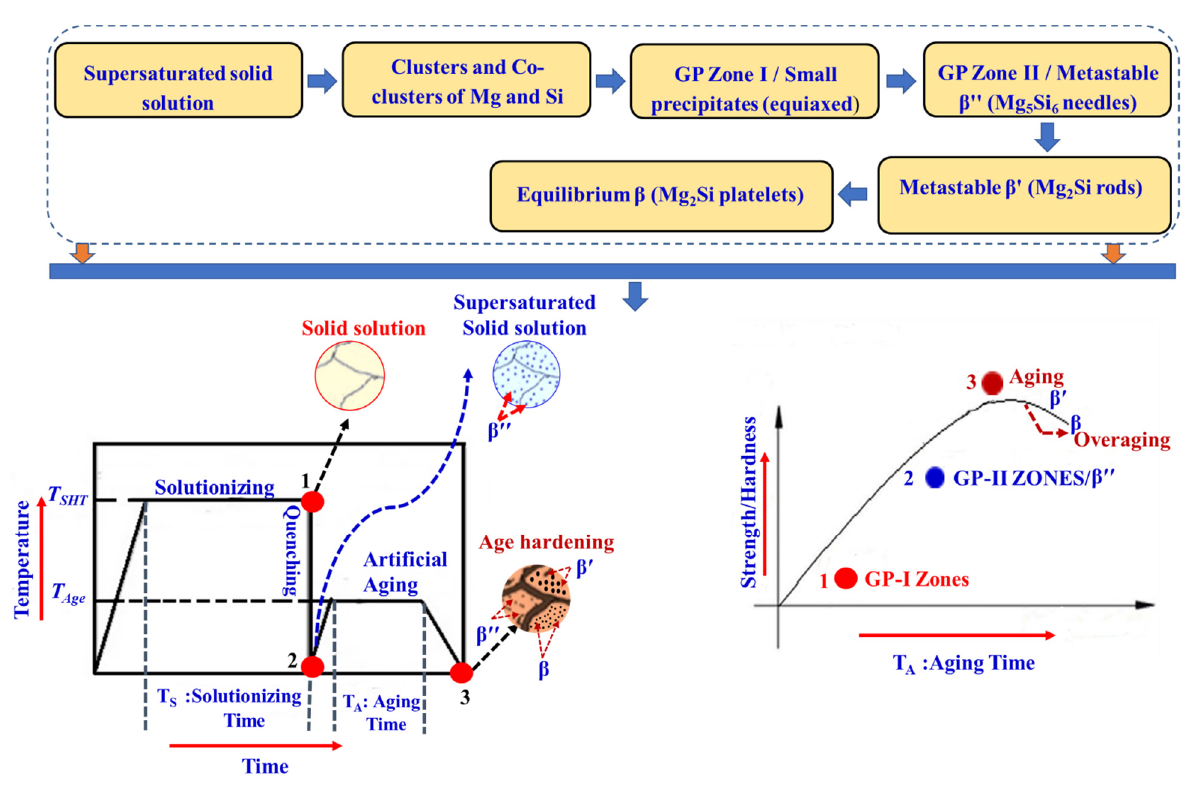
Figure 6. Precipitation sequence of Al-Si-Mg alloy.